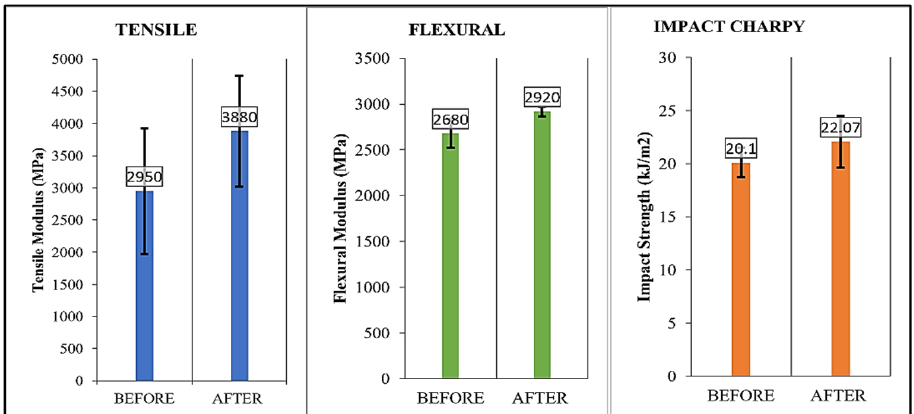
Figure 12. The change in modulus and strength after autoclave temperature pressurization.